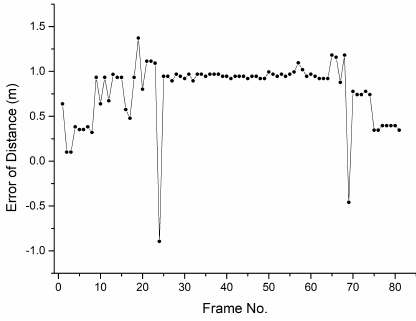
Figure 14. Error of distance.